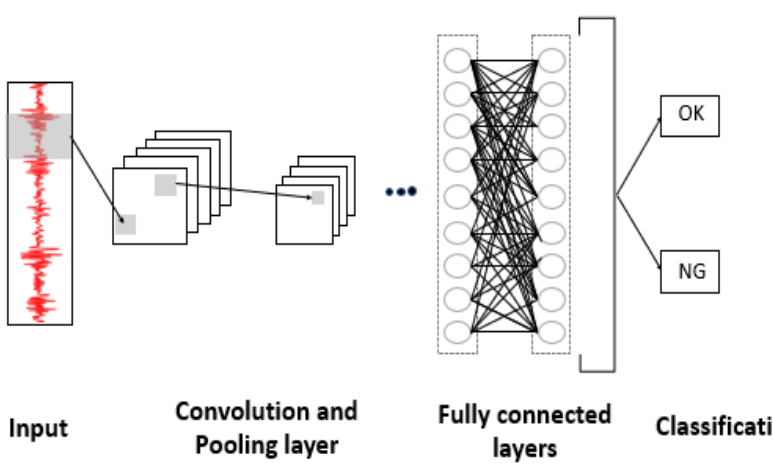
Figure 3. Structure of the convolution neural network.